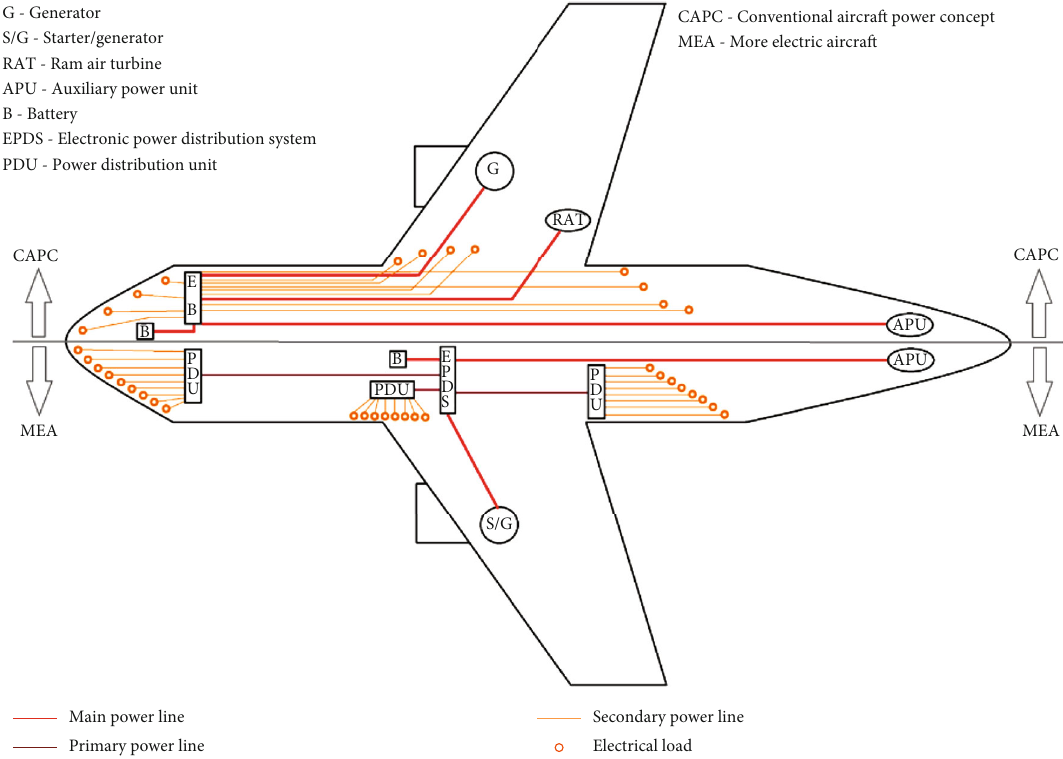
Figure 4: The comparison of centralised (top portion) and decentralised (bottom portion) distribution